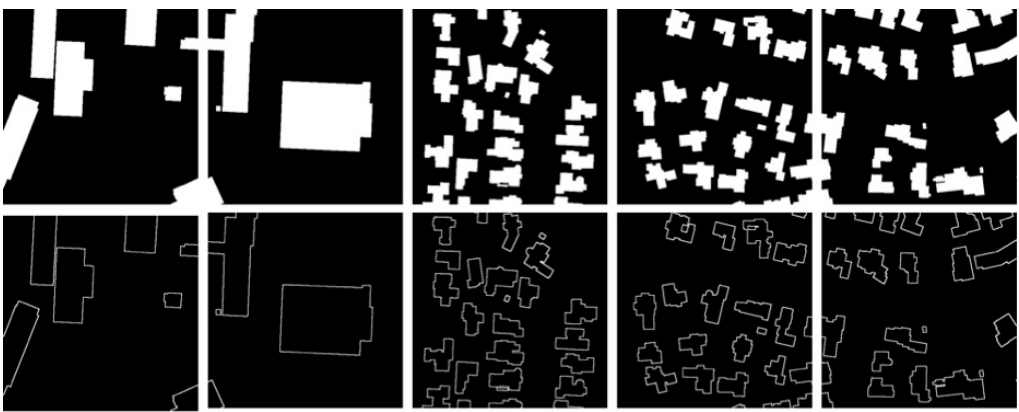
Figure 4. The boundary maps in the second row are generated from the building mask map in the first row through Algorithm 3.